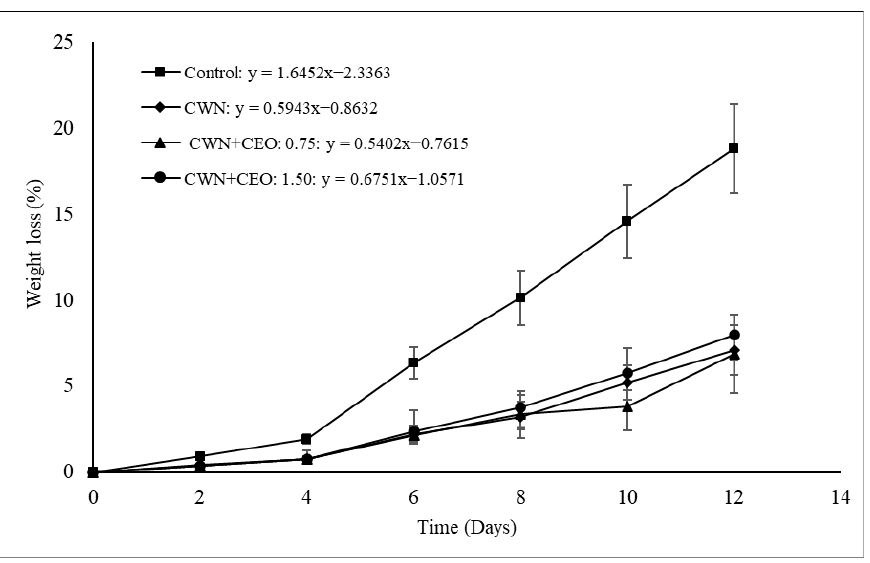
Figure 1 . Weight loss (%) of control and coated papaya Control: uncoated fruit; CWN: carnauba wax nanoemulsion at 9% of solid phase in suspension; CEO: C. martinii essential oil at 0.75% or 1.50%.